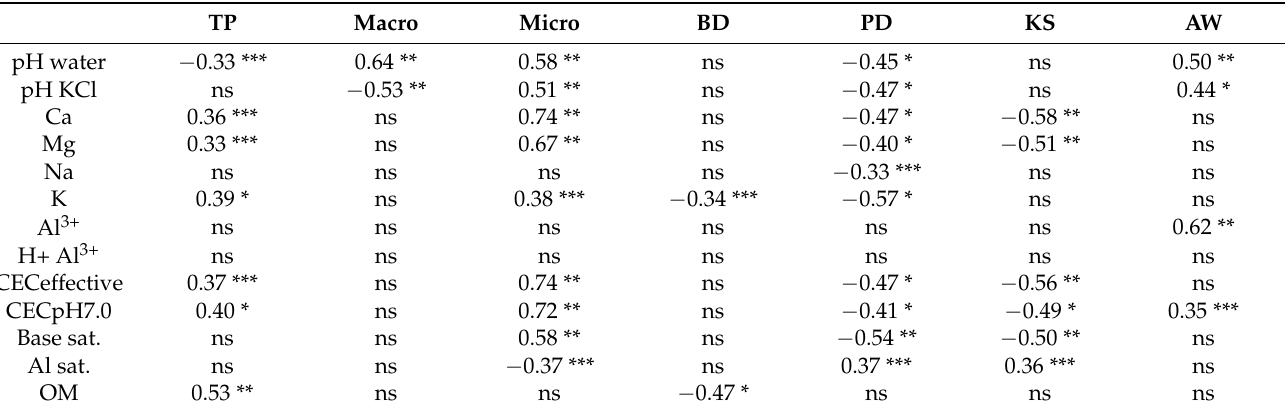
Table 11. Pearson’s correlation between the soil chemical and physical–hydric properties of Quartzip- samments of the Southwest of Rio Grande do Sul State, southern